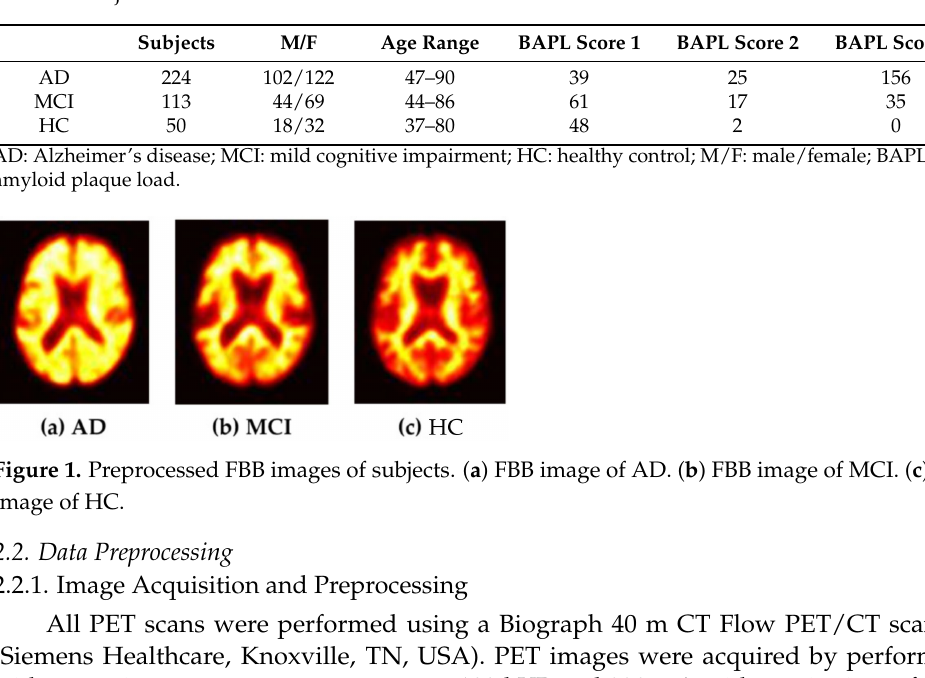
Table 1. Subject characteristics.